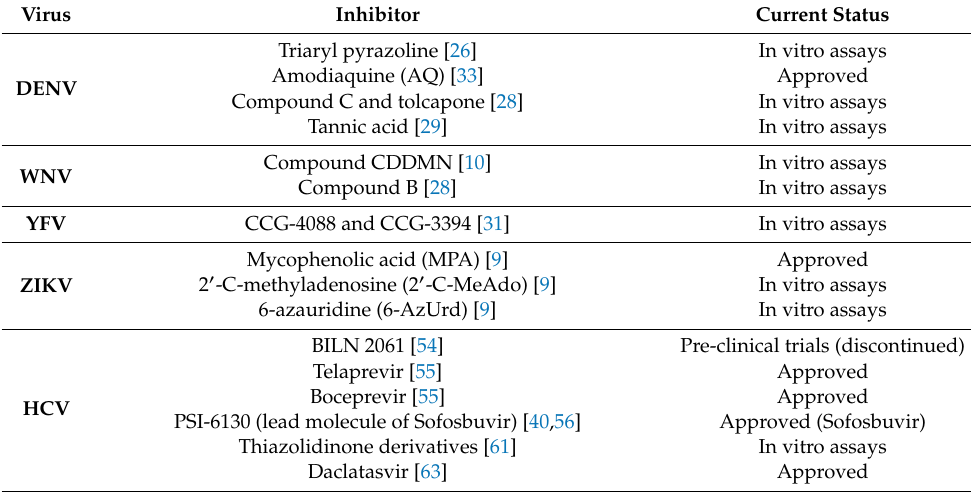
Table 1. Compounds identified as antiviral inhibitors using replicon-based